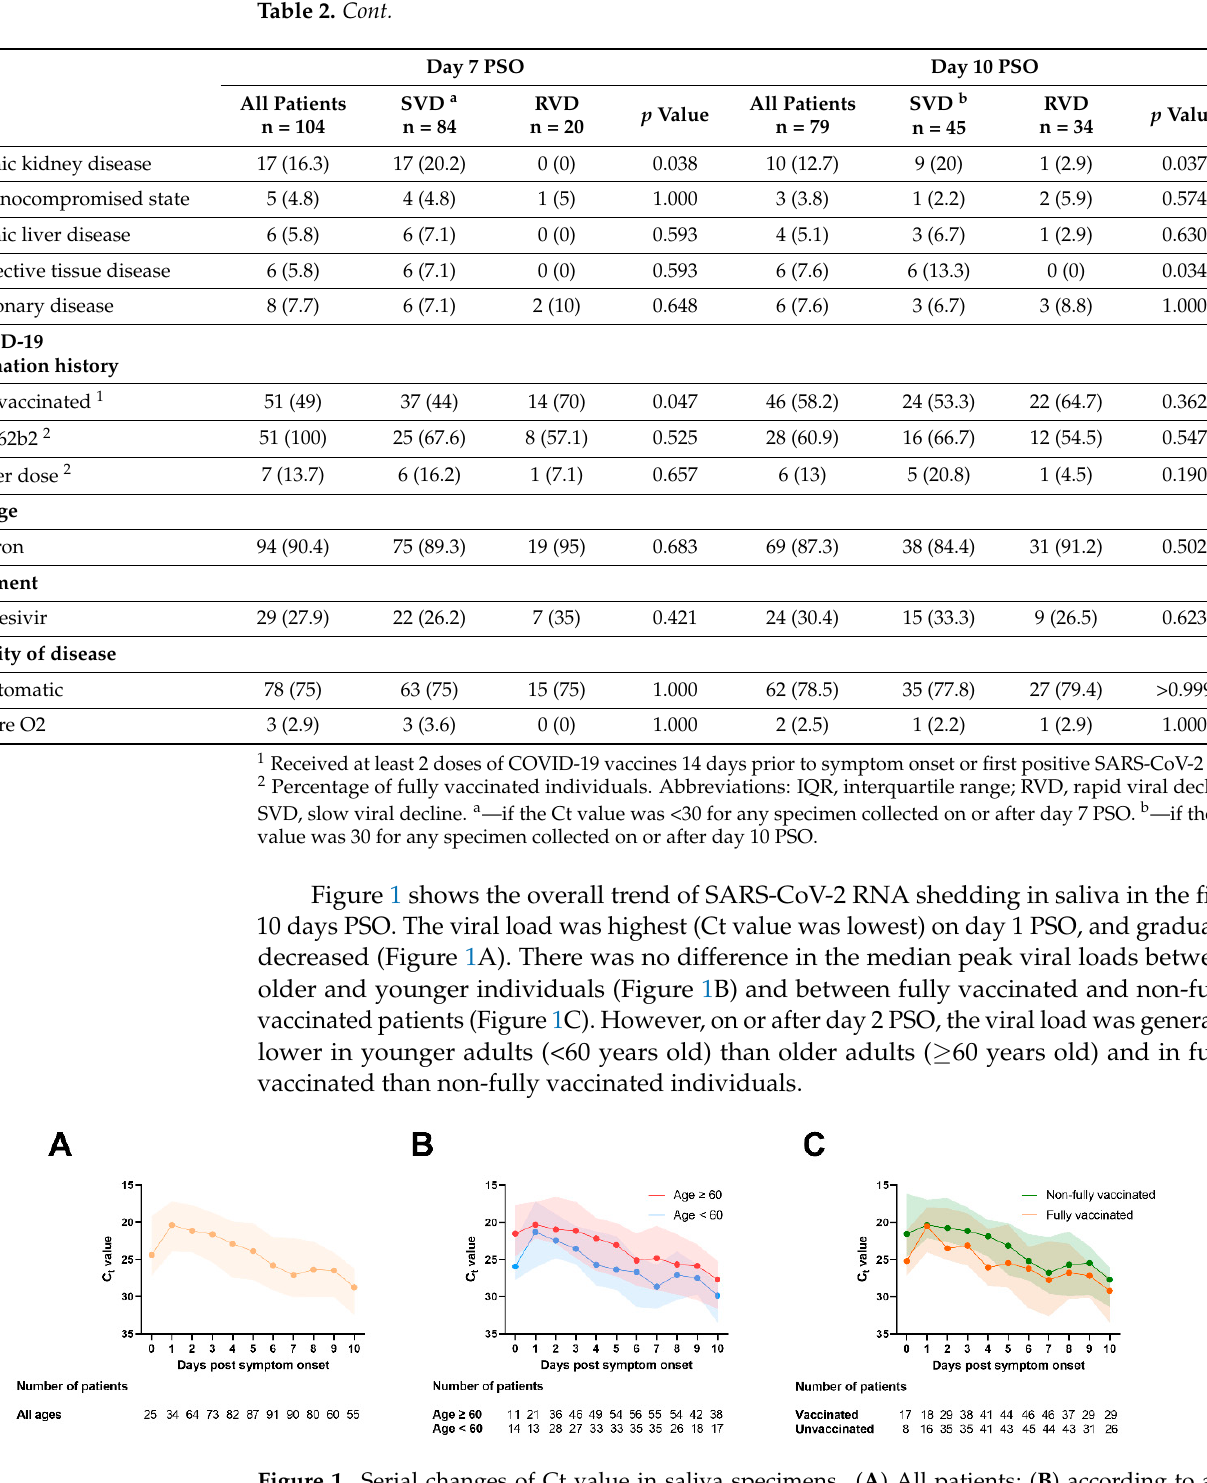
Figure 1. Serial changes of Ct value in saliva specimens. ( A ) All patients; ( B ) according to age; ( C ) according to vaccination status. Each dot represents the median viral load, and the shading represents the interquartile range.